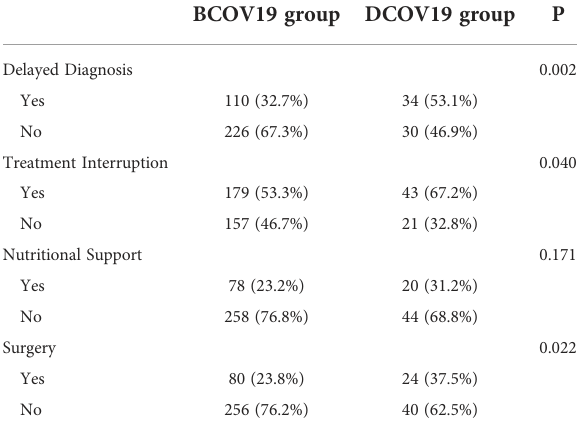
TABLE 2 Comparison of clinical characteristics in the two groups.